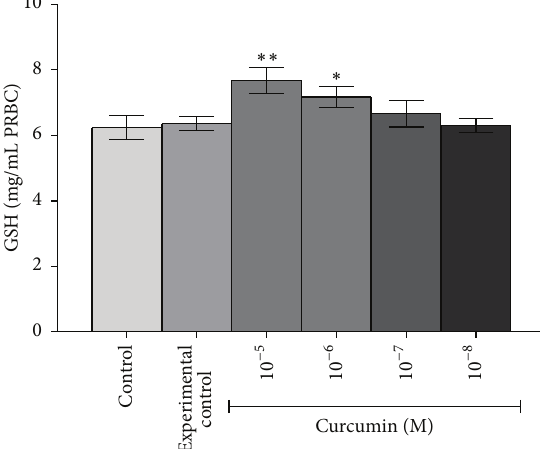
Figure 6: In vitro effects of curcumin (10 −5 M to 10 −8 M) on GSH concentration in Wistar rat RBCs. Concentration of GSH is expressed in mg/mL PRBCs. Values represent mean ± SD. Control represents erythrocytes receiving no treatment; experimental control: erythrocytes were incubated with solvent, that is, 0.1%